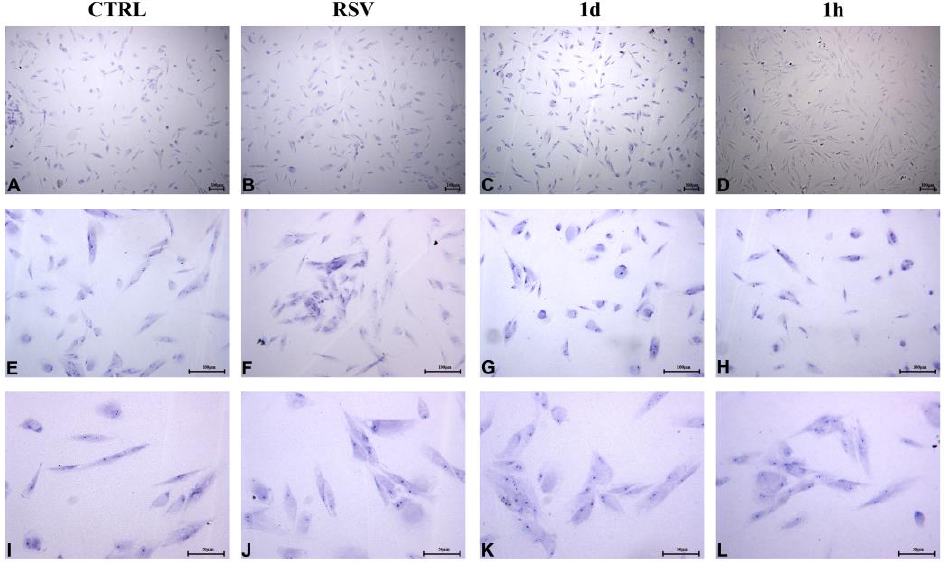
Figure 9. HGFs morphological and confluence analysis after the exposure to 1d and 1h for 48 h. Images were taken by an inverted microscope connected with a camera (Leica) at the magnifications of 40× ( A – D ), 100× ( E – H ), and 200× ( I – L ). (Scale bar: 100 µm for 40× and 100×; 50 µm for 200×).